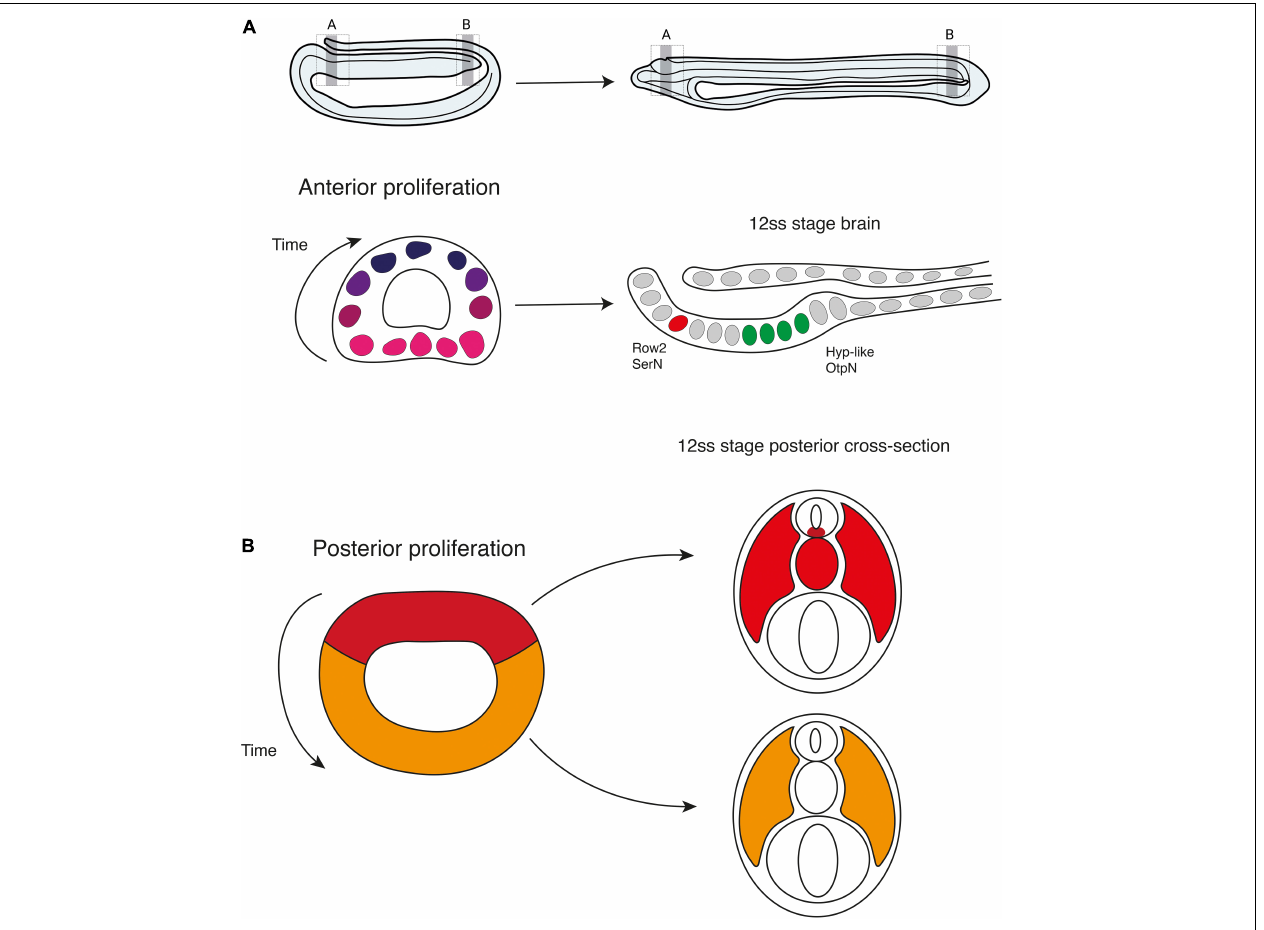
FIGURE 7 | Contributions of cell proliferation to nervous system and axial development. During neurulation, cell division is restricted to the anterior and posterior poles of the neural plate. (A) Anteriorly, the brain develops following a ventral to dorsal proliferative gradient. Ventral proliferation is required to specify Row2 serotonergic neurons of the frontal eye and hypothalamic-like Otp -positive neurons. (B) Posteriorly, early proliferating cells in the dorsal blastoporal region contribute to the floor plate, notochord, and somites, while progenitors in the ventral and lateral regions of the blastopore divide later and are incorporated into the posterior